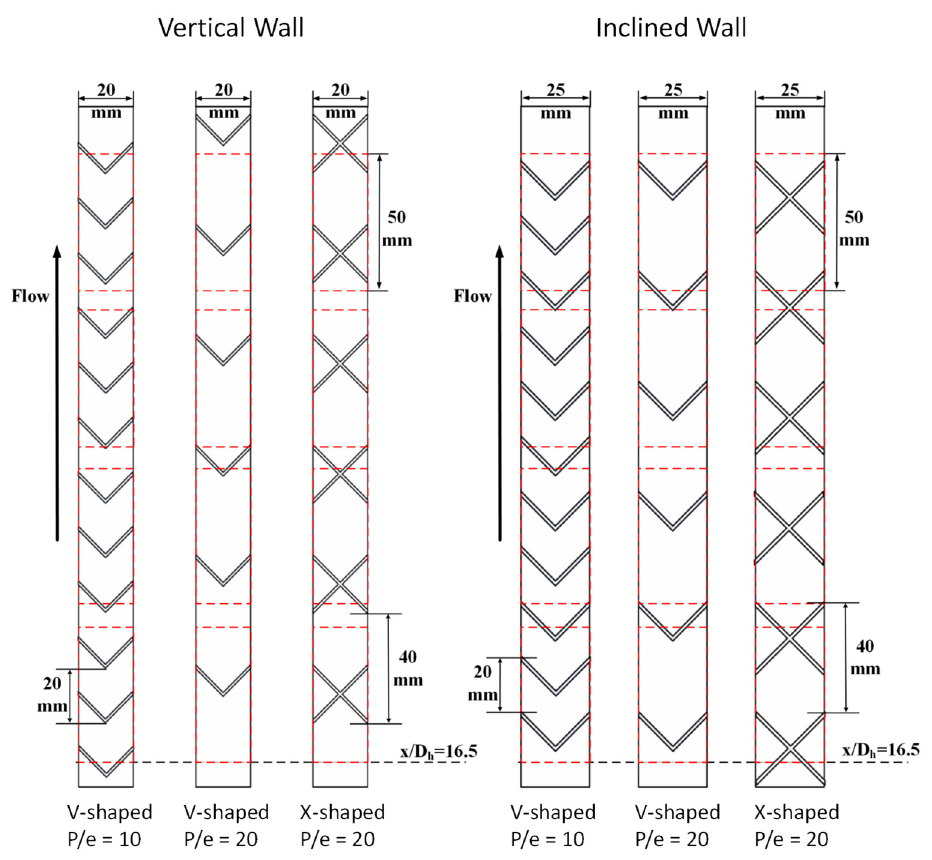
Figure 4. Rib configuration and measurement region in the flow channel.